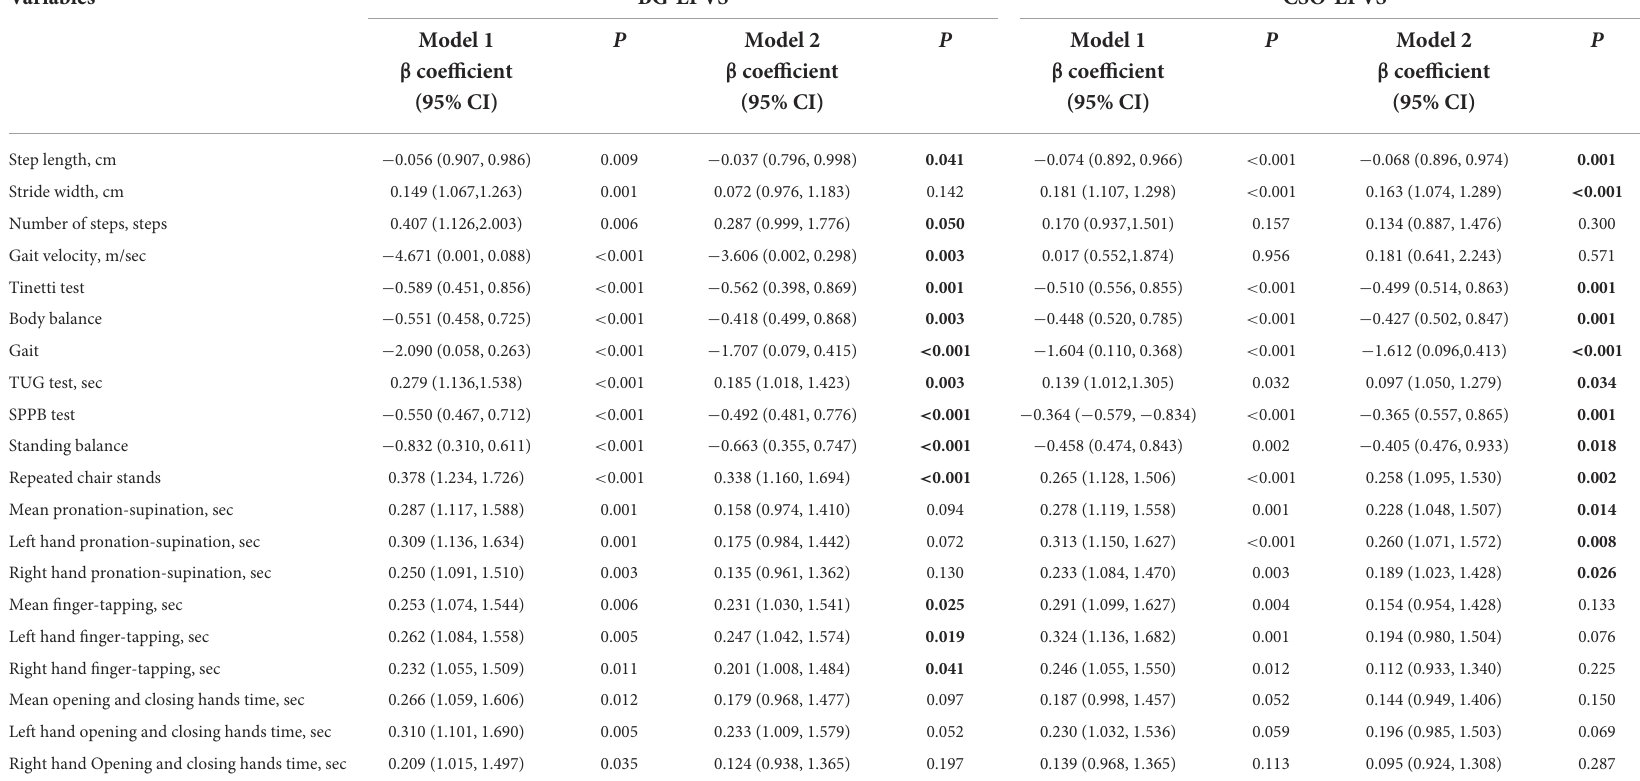
TABLE 3 Logistic regression analyses for the association between EPVS burden and movement